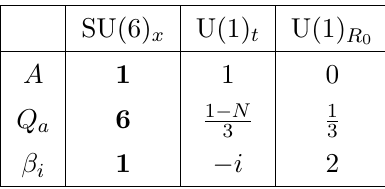
Table 1 . Transformation properties of the matter fields under the gauge